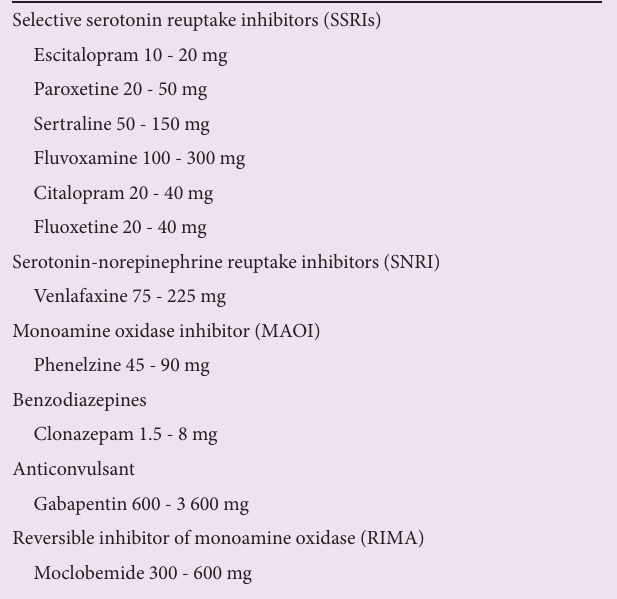
Table 1. Recommended daily drug doses for social anxiety disorder [10]